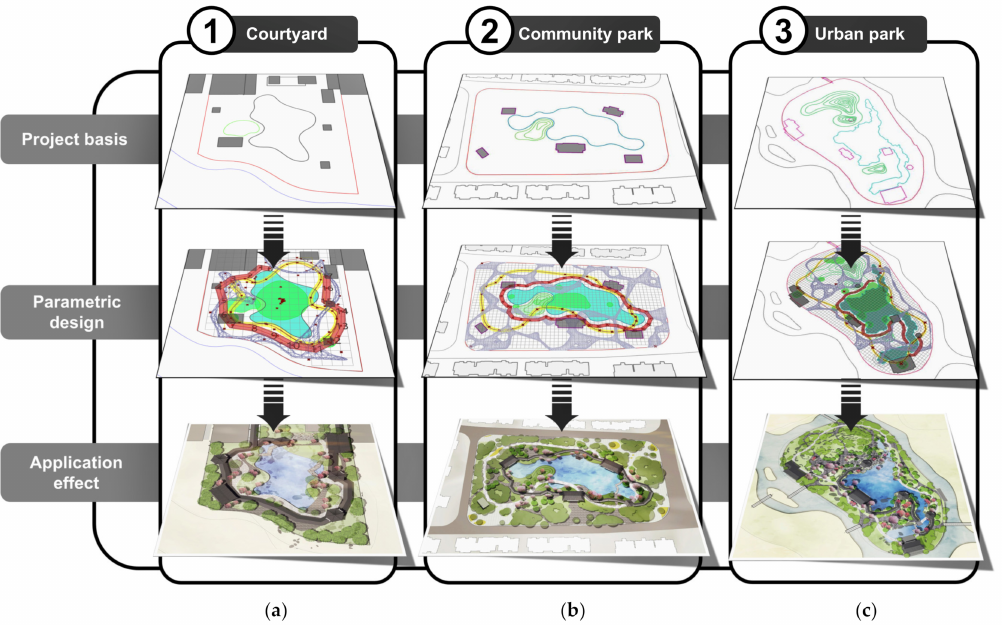
Figure 19. Parametric application effect: ( a ) application effect on courtyard green space; ( b ) applica- tion effect on community park; and ( c ) application effect on urban park.